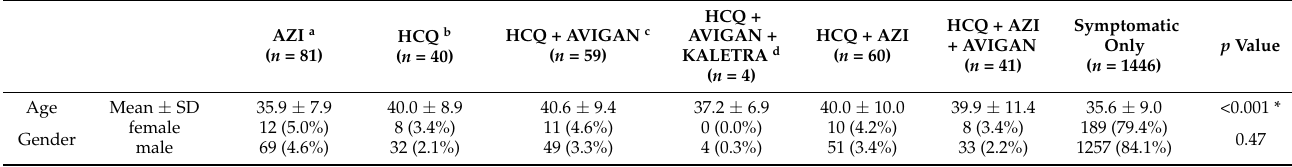
Table 1. Baseline demographic characteristics regarding the used protocols.